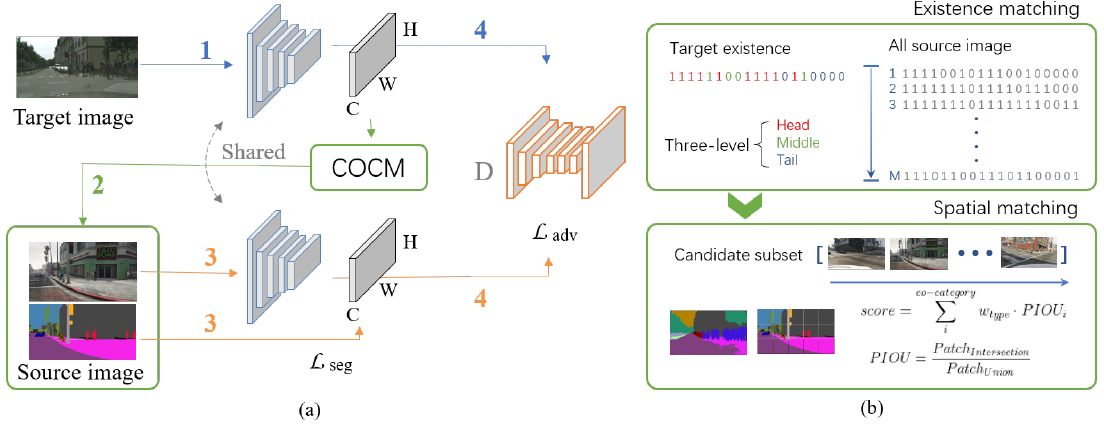
Figure 4. Overall frame of co-occurrence based consistent matching (COCM). The left side is the proposed training flow.Our proposed COCM follows step 1 in the vanilla DASS algorithm as step 2. Therefore, steps 2 and 3 in vanilla DASS algorithm become steps 3 and 4. The right side shows the details of COCM, and from top to bottom are the two steps of existence and spatial